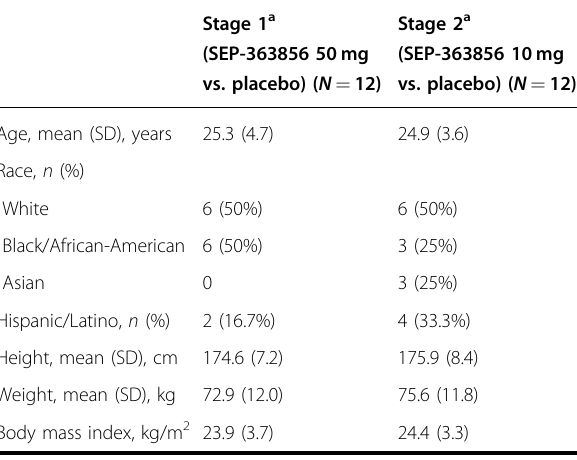
Table 1 Baseline characteristics of safety